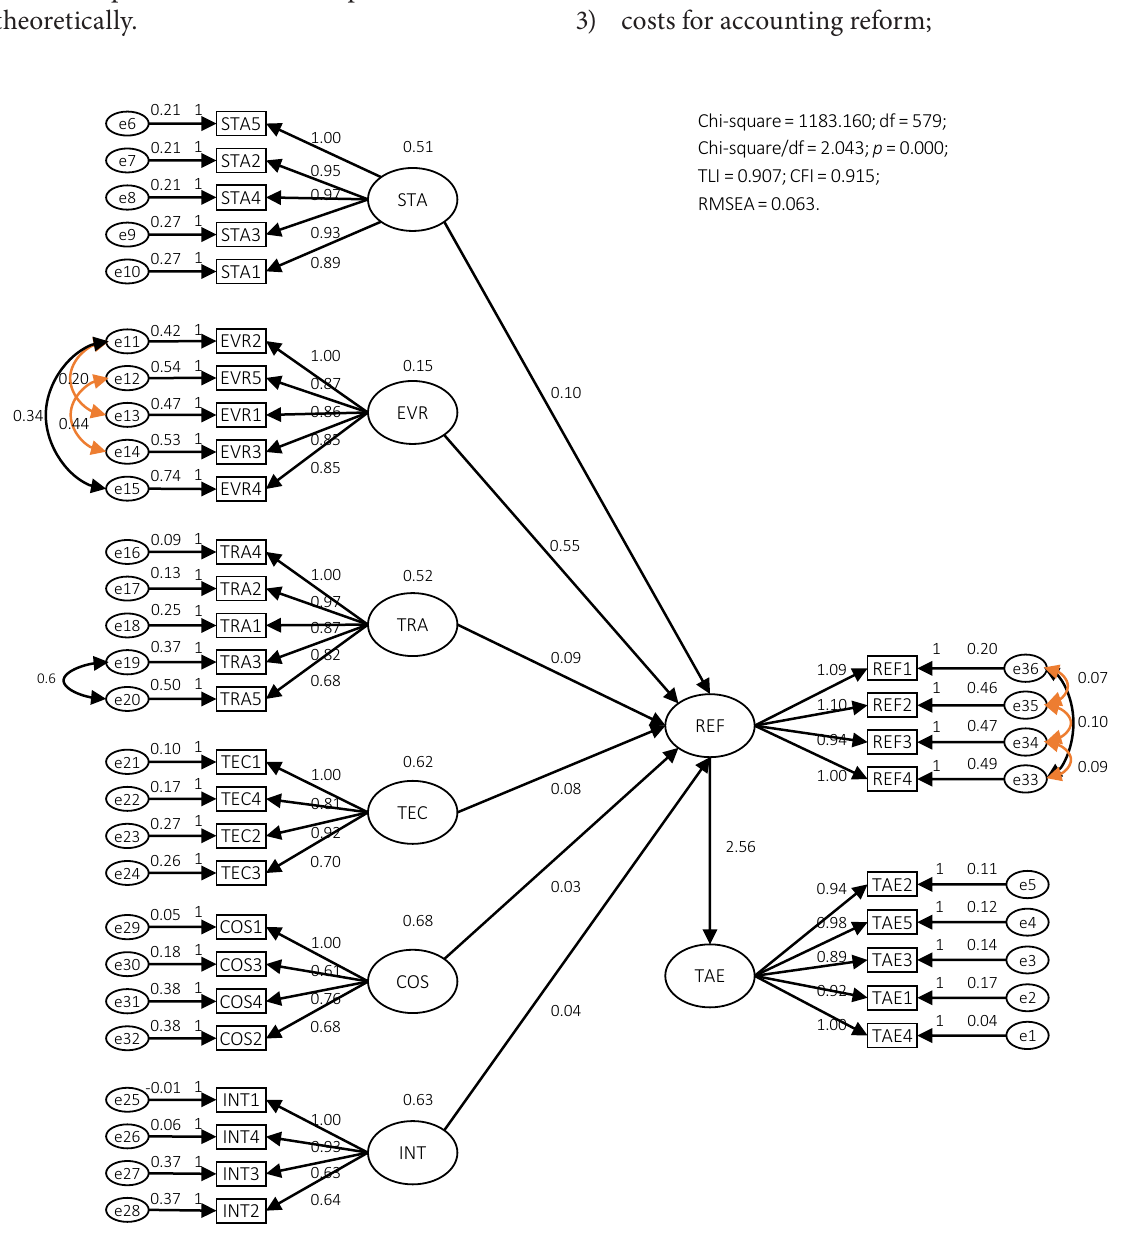
Figure 3. Testing of SEM (unstandardized